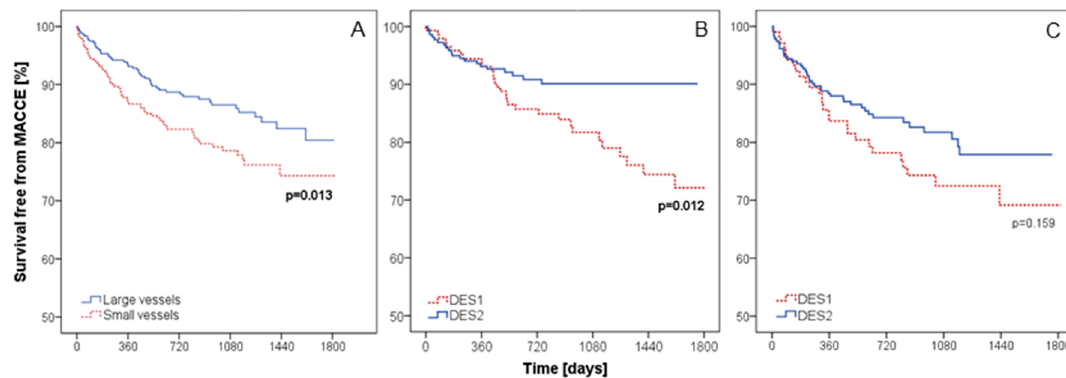
Figure 4. Kaplan–Meier curves for long-term survival free from MACCEs in all patients depending on the size of the vessel ( A ), large vessels group ( B ), and small vessels group ( C ) depending on the type of DES. MACCE—major adverse cardiac and cerebrovascular events, DES—drug-eluting stent.